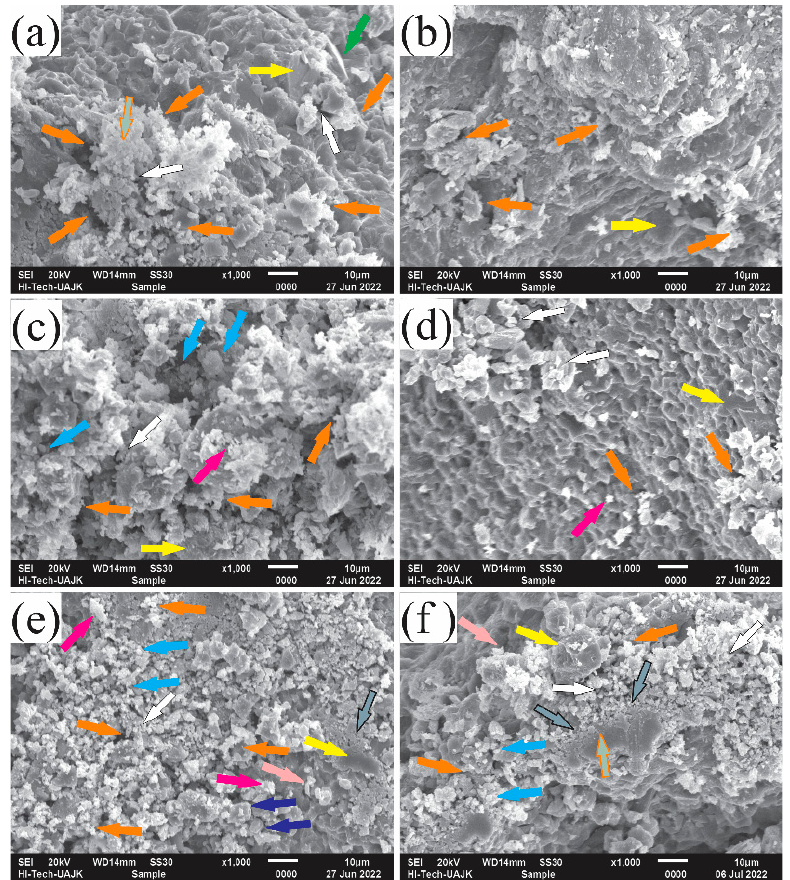
Figure 15. SEM image of shale and limestone samples from Early–Middle Eocene strata. ( a , b ) Images of the samples obtained from the base of the section; ( c , d ) Images of the samples taken from the middle of the Margalla Hill Limestone; ( e , f ) Images denote samples obtained from top of Margalla Hill Limestone. Yellow arrows denote calcite crystals, indigo blue arrows denote dolomite crystals, orange–brown arrows denote drusy cement, white arrows denote blocky cement, sky blue arrows denote rim cement, light grey arrows with a red outline denote compacted illite, indigo arrows with a red outline denote montmorillonite clay, and black arrows with red outline denote chert grains as found by Prothero and Schwab [70]. Moreover, green arrows denote a fibrous column of calcite, light pink arrows denote mosaic (drusy) dolomite cement, silver arrows with a black outline denote granular cement, and dark purple arrows denote dog tooth calcite crystals as found by Flügel and Munnecke